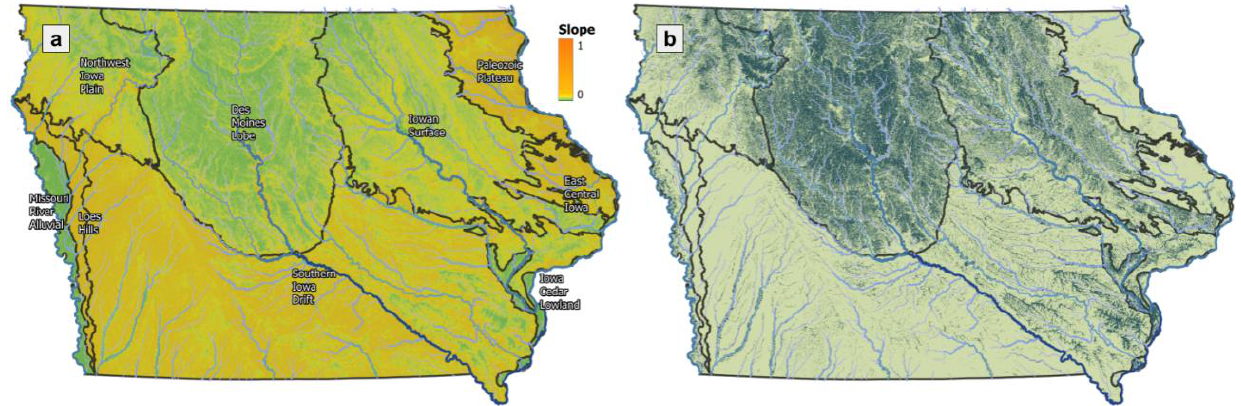
Figure 3. Maps of the hillslope steepness ( a ) and tile drainage localization according to the Iowa DNR ( b